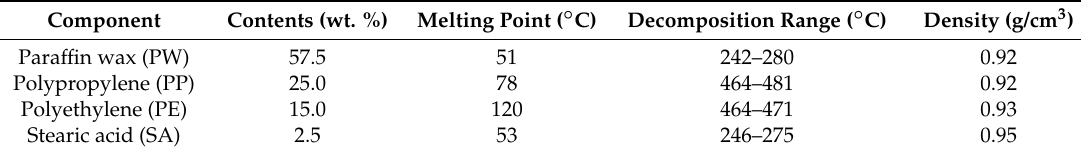
Table 2. Wax-polymer-based binder system.